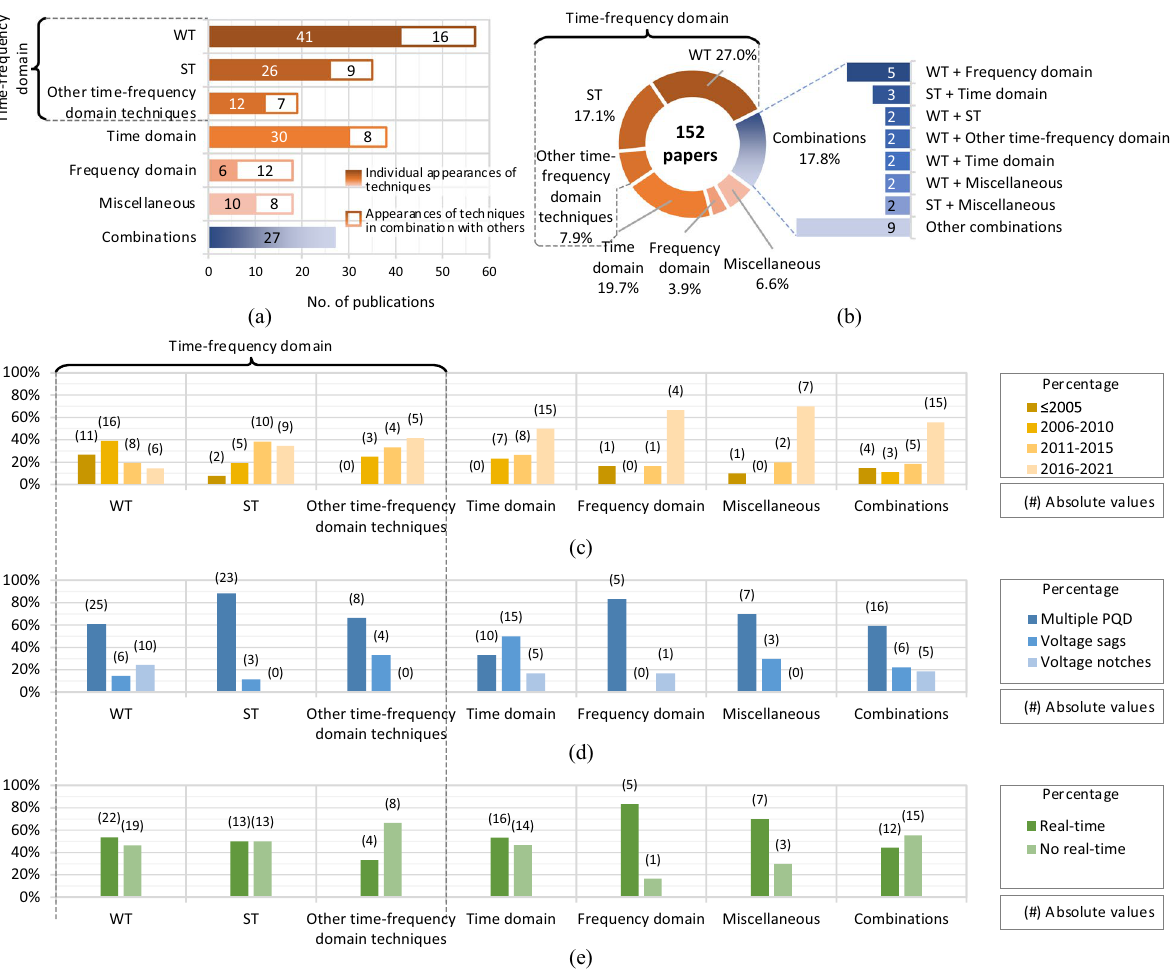
Fig. 9 Distribution of papers in the identified transformation techniques. a The number of papers, b percentages and number of papers that use a combination of techniques, c percentages and number of papers from the time perspective, d the type of disturbance perspective, and e